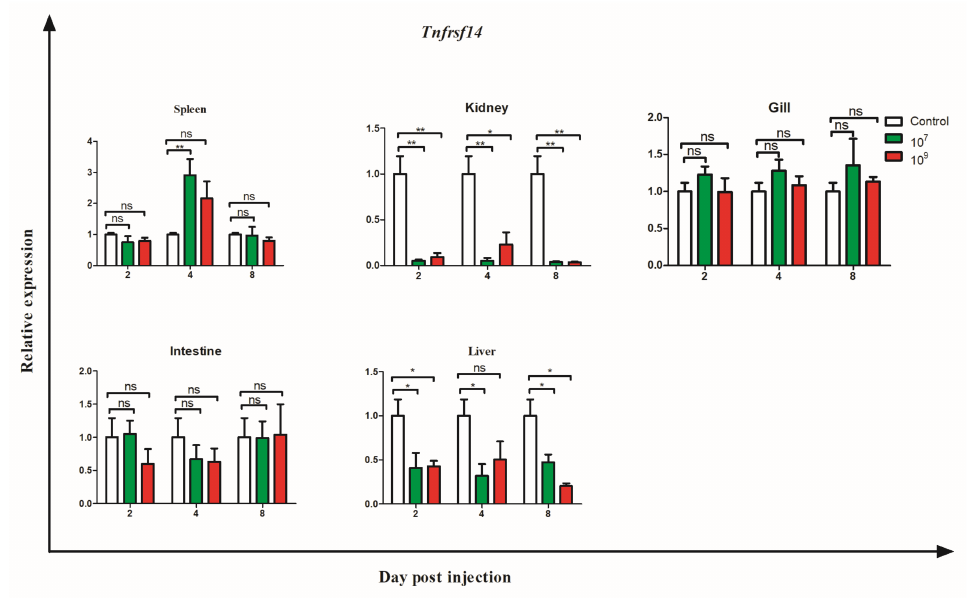
Figure 10. Expression analysis of tnfrsf14 after infection with K. peneumoniae . Fish were i.p. injected with 0.1 mL 1 × 10 7 or 1 × 10 9 CFU/mL K. pneumoniae suspension. Ef-1 α was used as an internal reference gene for normalization of gene expression. The expression levels of genes were compared with that of the control group (defined as 1). Bars represent mean + SEM ( n = 5). Significant differences are indicated by * ( p < 0.05) and ** ( p < 0.01). ns = no significant